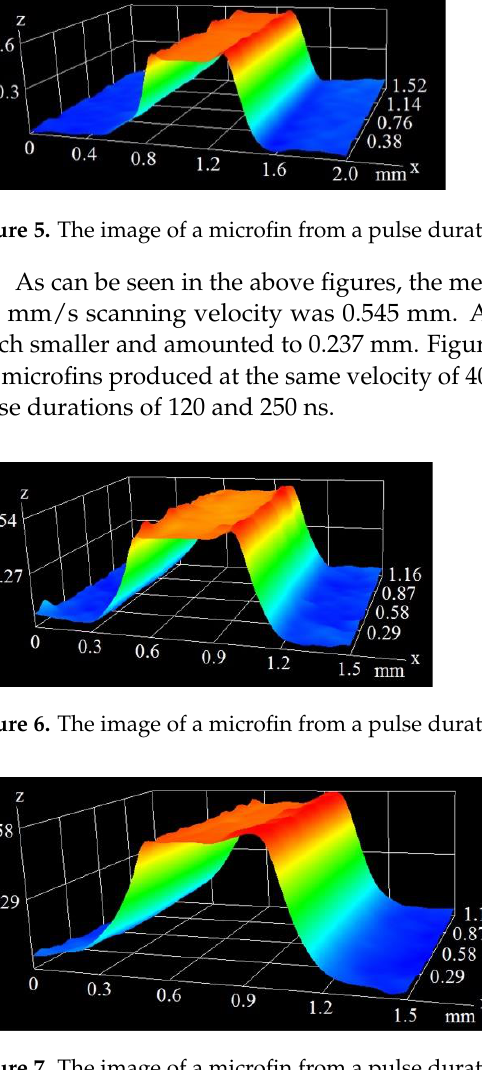
Figure 7. The image of a microfin from a pulse duration of 250 ns and velocity of 400 mm/s.